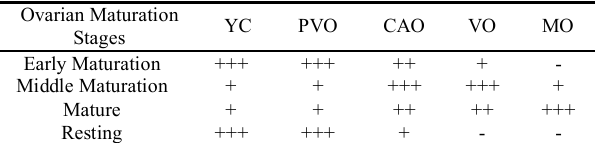
Table 1. Ovarian maturation stages of black triggerfish based on the occurrence of different oocyte development stages. (YC) young cell; (PVO) previtellogenic oocyte; (CAO) cortical alveoli oocytes; (VO) vitellogenic oocytes; and (MO) mature oocytes (- absent, + present, + + frequent, + + +